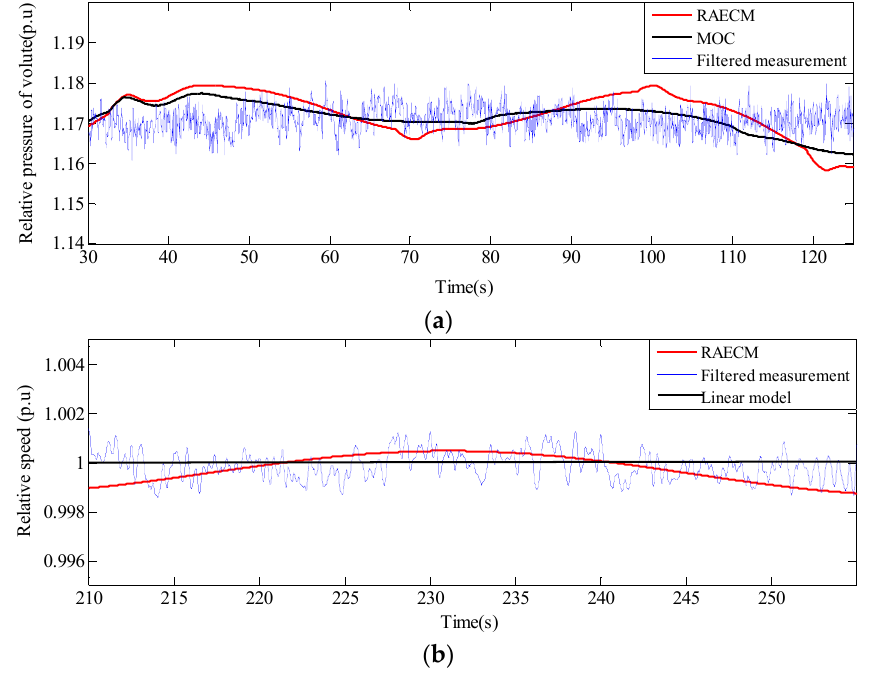
Figure 17. Comparison diagram of dynamic parameters in the no-load condition with diverse models: ( a ) relative pressure of value; ( b ) rotational speed. Table 4. The index values of diverse models in the on-load condition. Pressure at Volute (p.u) Model